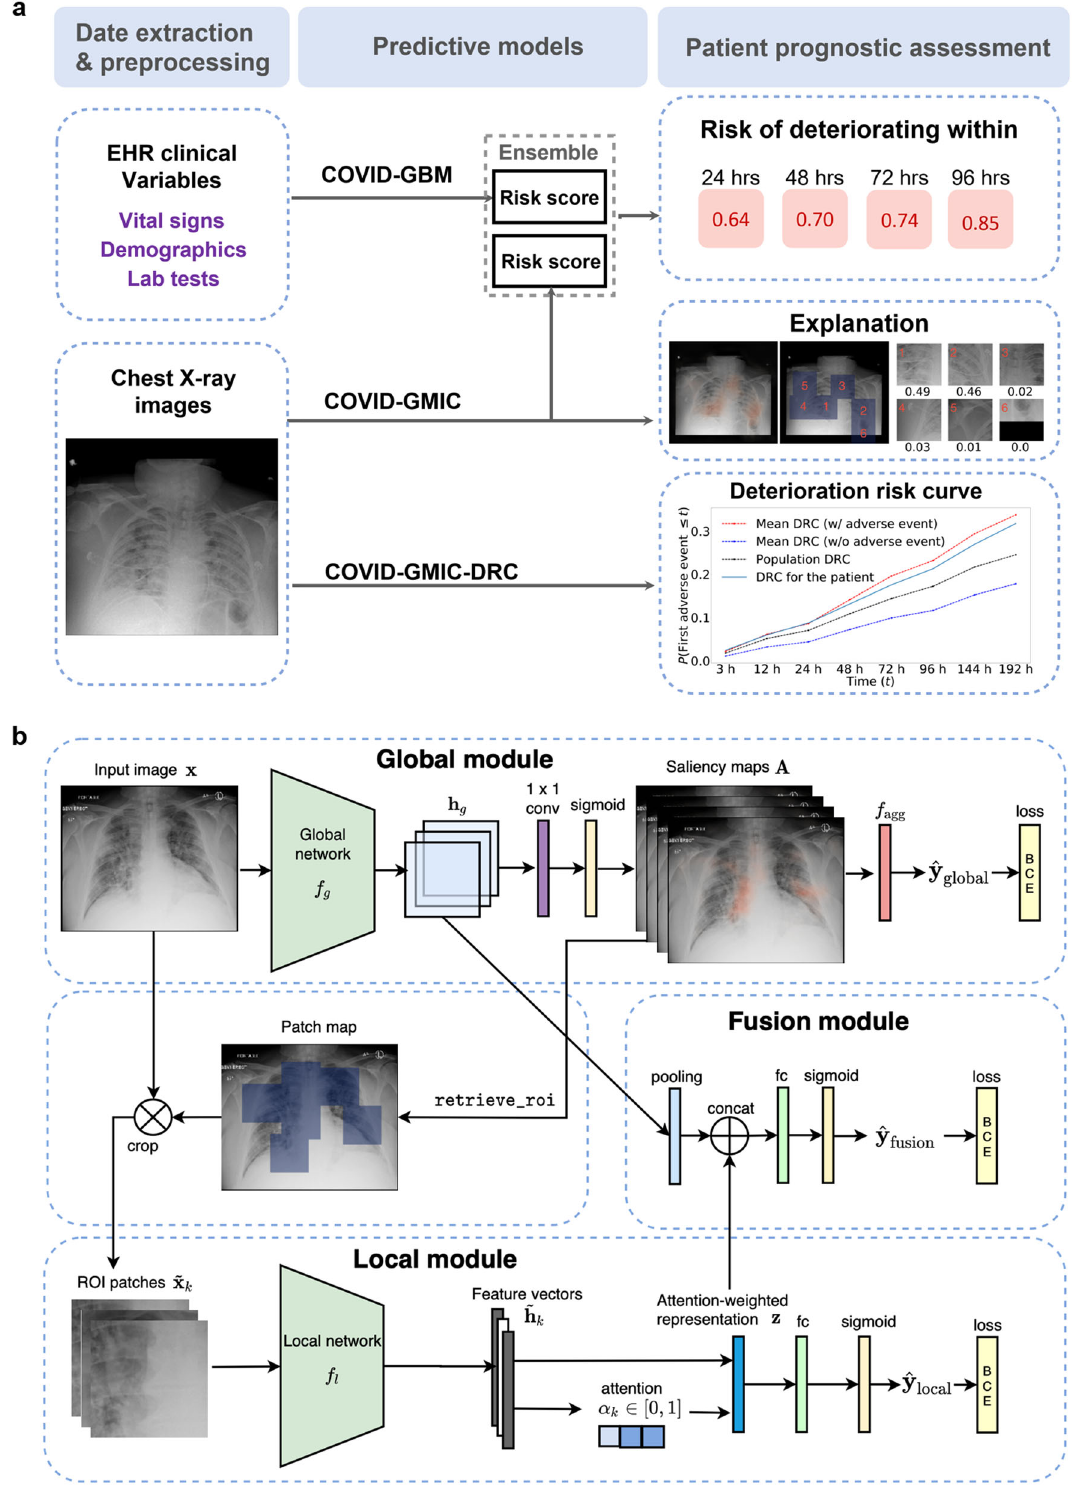
variables using a gradient boosting model (GBM) 28 , denoted as COVID-GBM. Both models were trained using a dataset of 3661 patients admitted to NYU Langone Health between March 3, 2020, and May 13, 2020. To learn from both modalities, we combined the output predictions of COVID-GMIC and COVID-GBM to predict each patient ’ s overall risk of deterioration over different